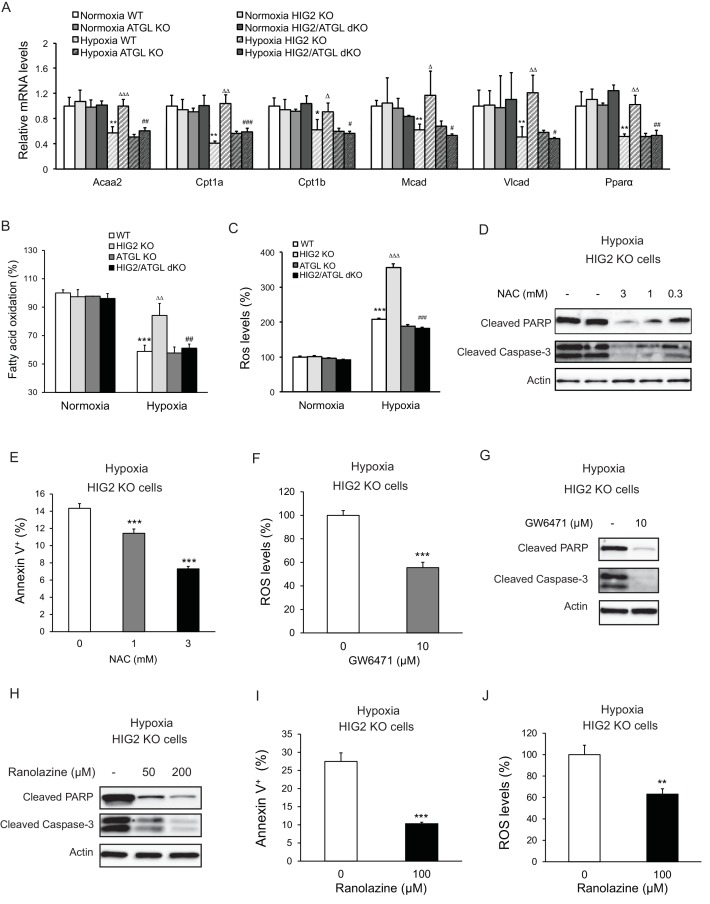
Enhancement of lipolysis in the absence of HIG2 increases PPARα activity, FAO rate and ROS production under hypoxia.(A–C) After 36 hr of incubation under normoxia or hypoxia, mRNA levels (A), FAO (B) and ROS levels (C) were measured in HCT116 clone cells. Acaa2, acetyl-CoA acyltransferase 2; Cpt1a, carnitine palmitoyltransferase Ia; Cpt1b, carnitine palmitoyltransferase Ib; Mcad, Medium-chain acyl-CoA dehydrogenase; Vlcad, very-long-chain acyl-CoA dehydrogenase. n = 4 (WT, HIG KO) or 3 (ATGL KO, HIG2/ATGL KO) biologically independent experiments for (A); n = 5 (WT, HIG KO) or 3 (ATGL KO, HIG2/ATGL KO) biologically independent experiments for (B); n = 2 biologically independent experiments for (C). *p<0.05, **p<0.01, ***p<0.001 vs. Normoxia WT; ∆p<0.05, ∆∆p<0.01, ∆∆∆p<0.001 vs. Hypoxia WT; #p<0.05, ##p<0.01, ###p<0.001 vs. Hypoxia HIG2 KO. (D, E) HCT116 cells were cultured under hypoxia in the presence or absence of various concentrations of NAC for 48 hr. Cell apoptosis was determined by immunoblotting (D) or by staining with Annexin V for Flow Cytometry (e). n = 3 biologically independent experiments. ***p<0.001 vs. without NAC treatment. (F) ROS levels in HCT116 cells were determined by H2DCFDA after 36 hr of treatment with10 µM GW6471 under hypoxia. n = 3 biologically independent experiments. ***p<0.001 vs. without GW6471 treatment. (G) Protein levels of apoptosis markers in HCT116 cells after 48 hr of treatment with 10 µM GW6471 under hypoxia. (H–J) HCT116 cells were cultured under hypoxia in the presence or absence of ranolazine. After 48 hr of treatment, cell apoptosis was determined by immunoblotting (H) or by staining with Annexin V for Flow Cytometry (I). Intracellular ROS levels (36 hr of treatment) were determined by H2DCFDA (J). n = 3 biologically independent experiments. **p<0.01, ***p<0.001 vs. without ranolazine treatment. Graphs represent mean ±SD, and were compared by two-tailed unpaired Student t-test.